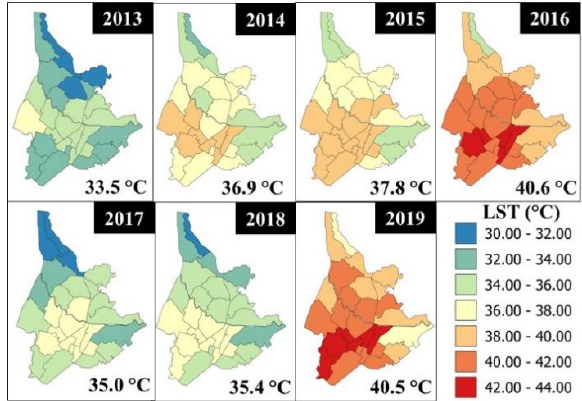
Figure 3. Barangay-level average LST maps of Mandaue City